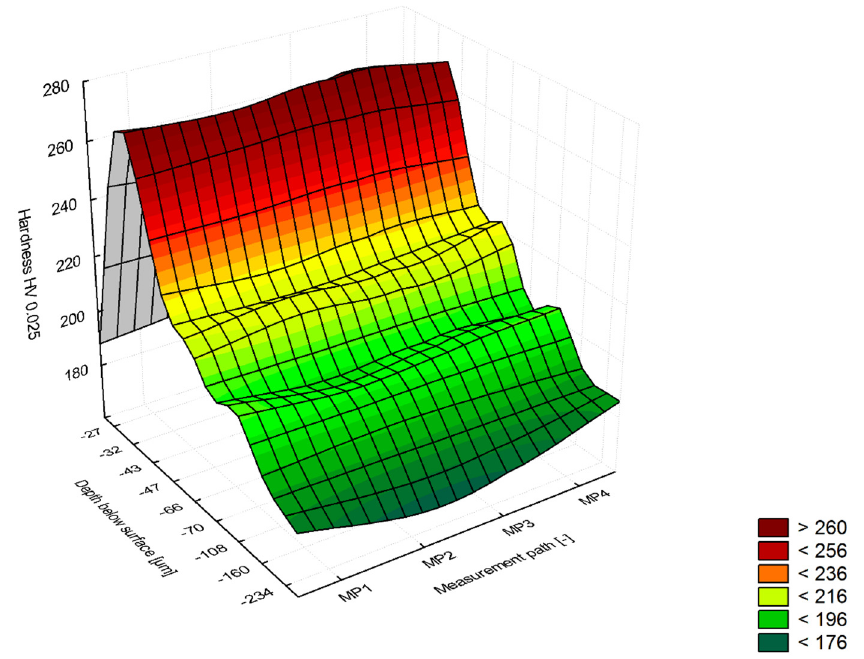
Figure 11. Microhardness HV0.025 measurements results of the E215 low ‐ carbon steel rivets after riveting process.